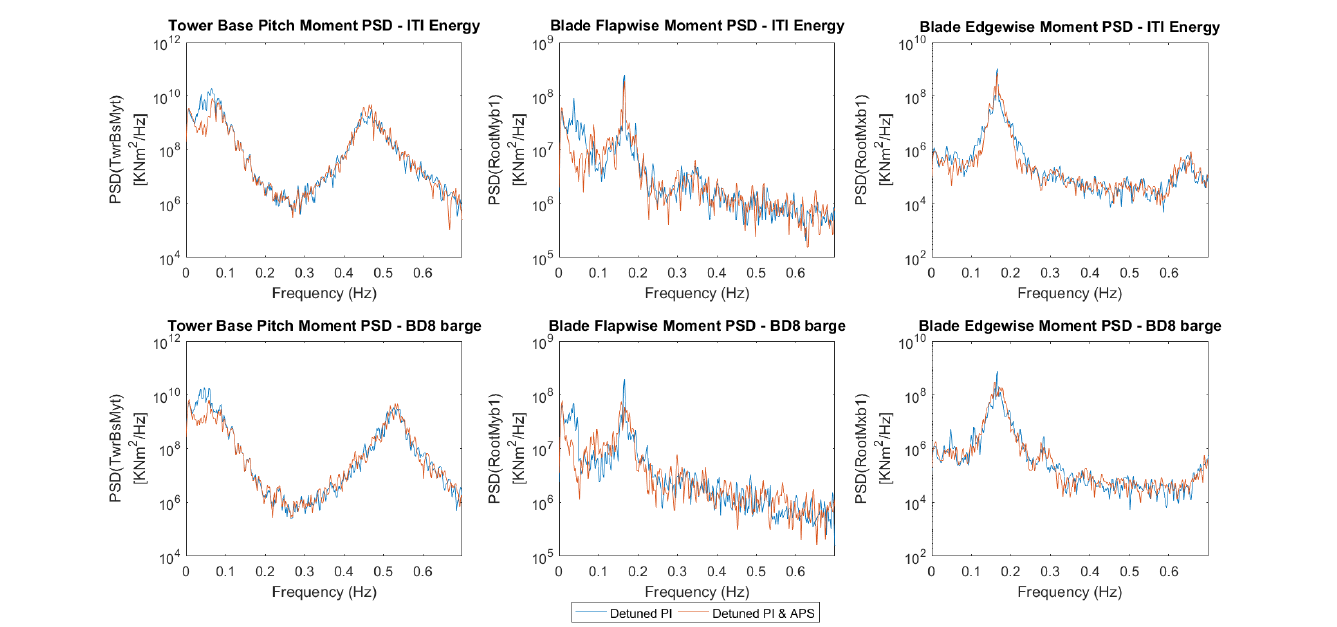
Figure 9. Blade-root and tower-base bending moments PSD